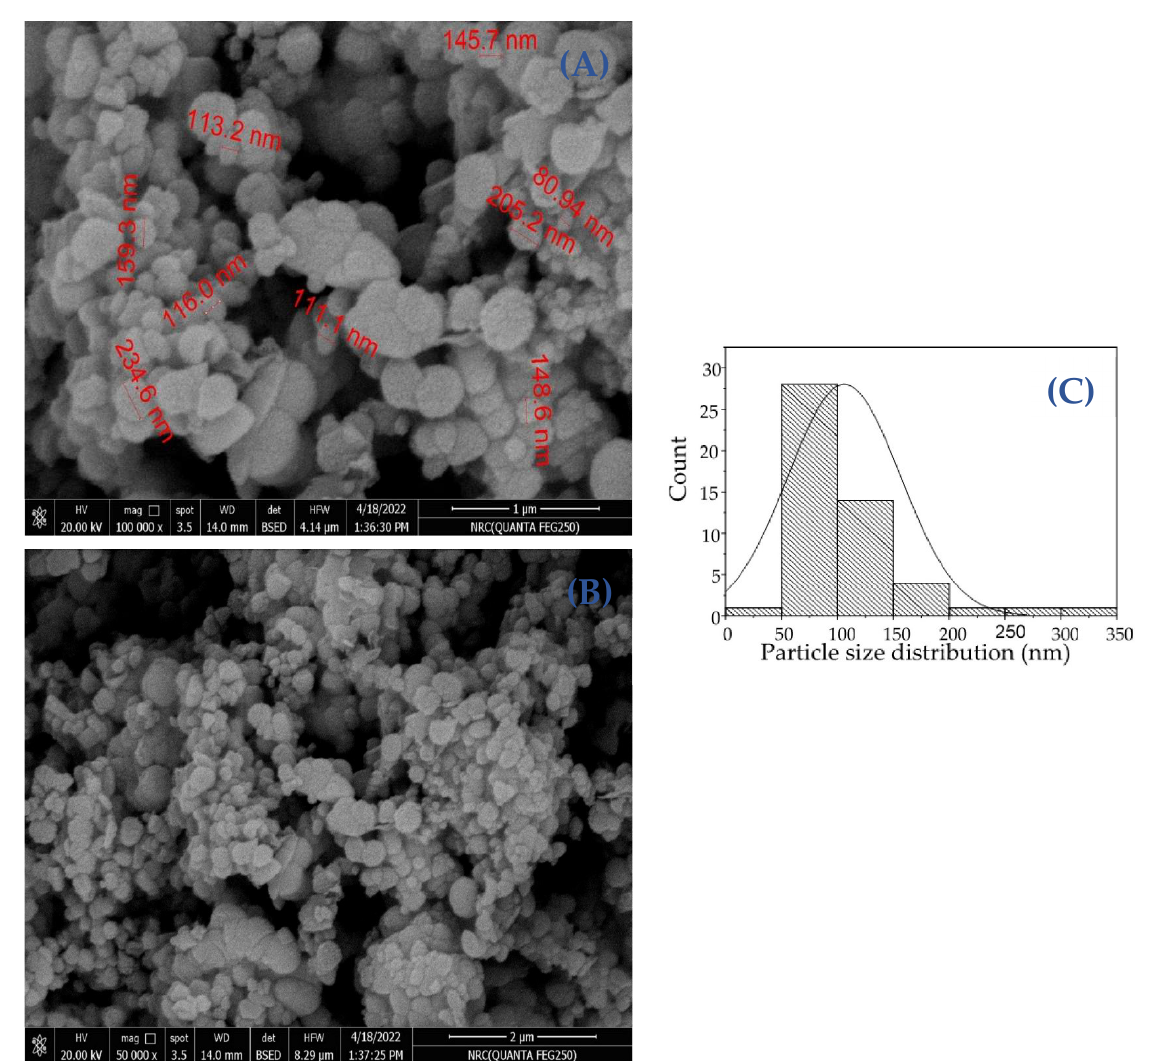
Figure 8. ZnO-NPs SEM image ( A , B ) and a histogram of the particle size distribution ( C ). Molecules 2023 , 28 , x FOR PEER REVIEW